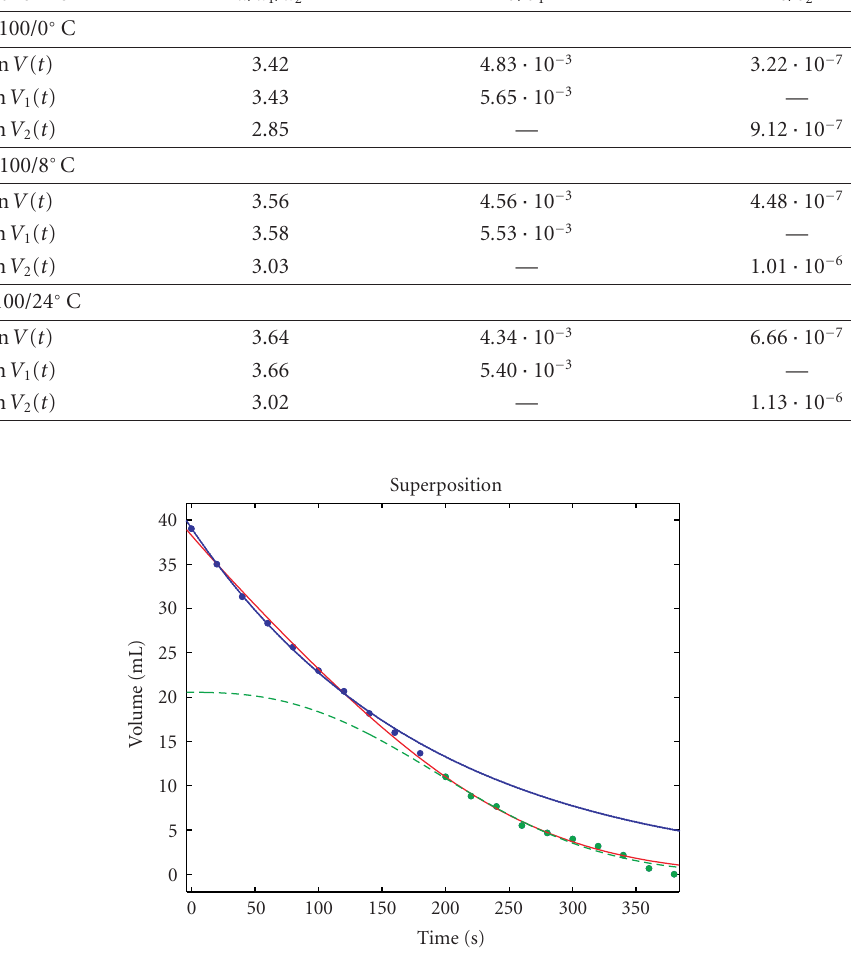
Table 3.1. Temperature dependence of the coe ffi cients for Beck’s Pils in the (20/100) experiments. Beck’s Pils